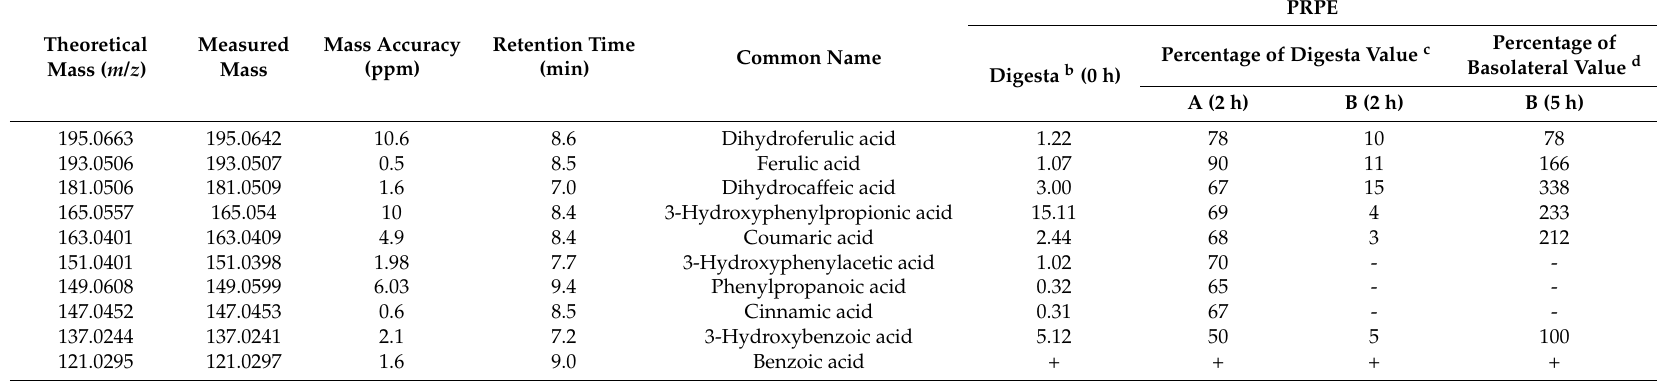
Table 2. Polyphenols and their metabolites in PRPE digesta ( t = 0 h) and amount expressed as a percentage of initial digesta values in the apical ( t = 2 h) and basolateral ( t = 2 h) chambers in the Caco-2 cell transport bioassay and basolateral ( t = 5 h) chamber in the HepG2 cell metabolism bioassay a .